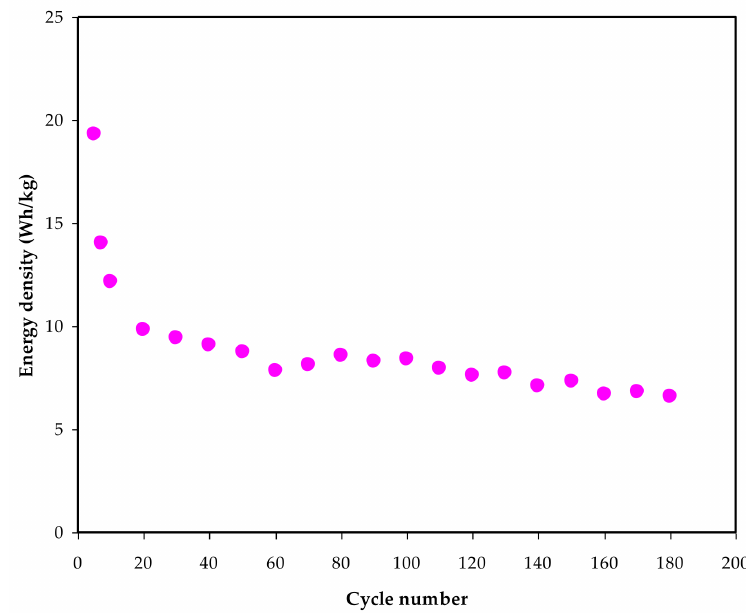
Figure 11. Energy density ( E d ) versus cycle number for 180 cycles.